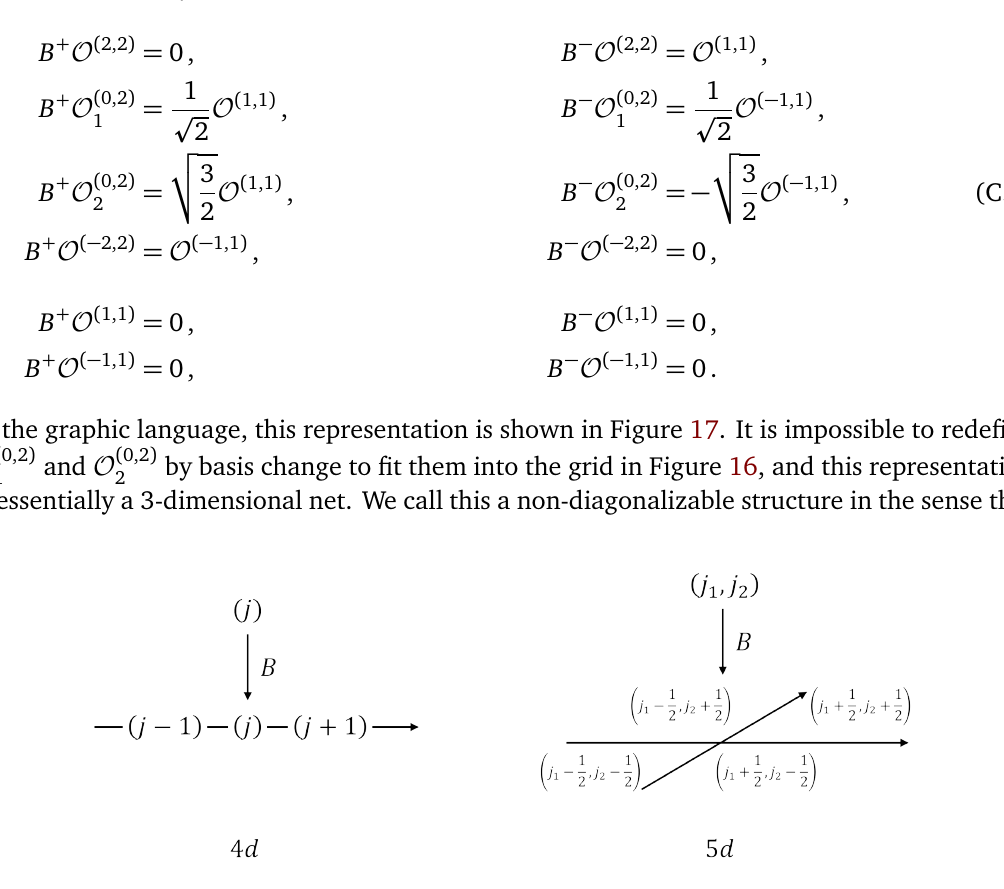
Figure 15: Since the SO ( 4 ) representations are labeled by ( j dimensional structure, the general net structure of 5 d CCA representation should be three